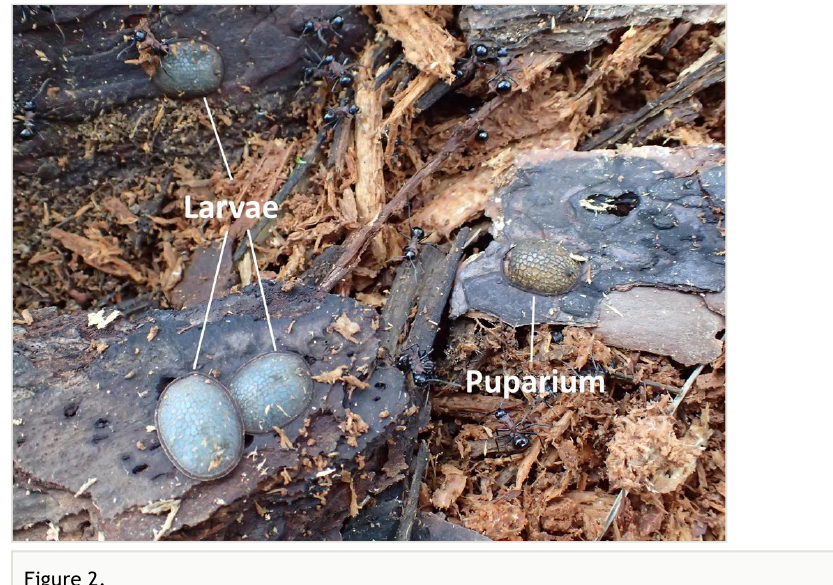
Figure 2. The microdontine larvae and puparia discovered in the P. lamellidens nest. Three larvae and one puparium were attached to pieces of bark.